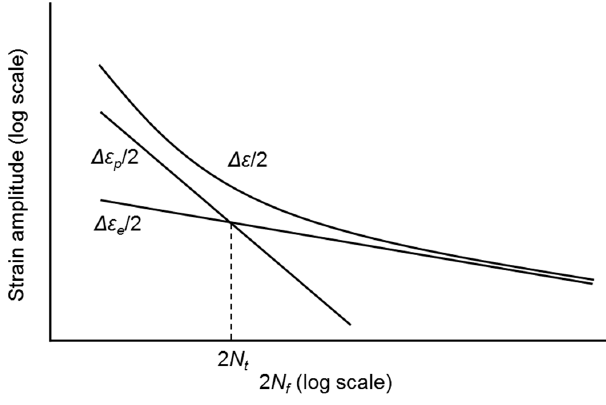
Figure 3. Plot of transition fatigue life.